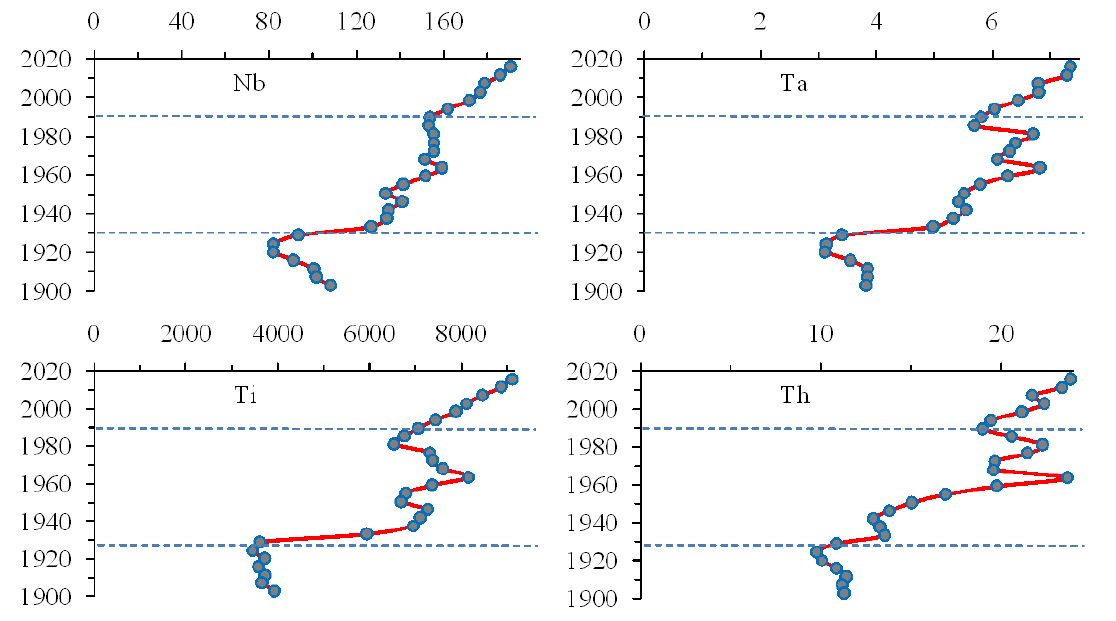
Figure 12. Vertical distribution of the content (µg/g) of Nb, Ta, Ti, and Th in the sediments of Lake Bolshoy Vudjavr.